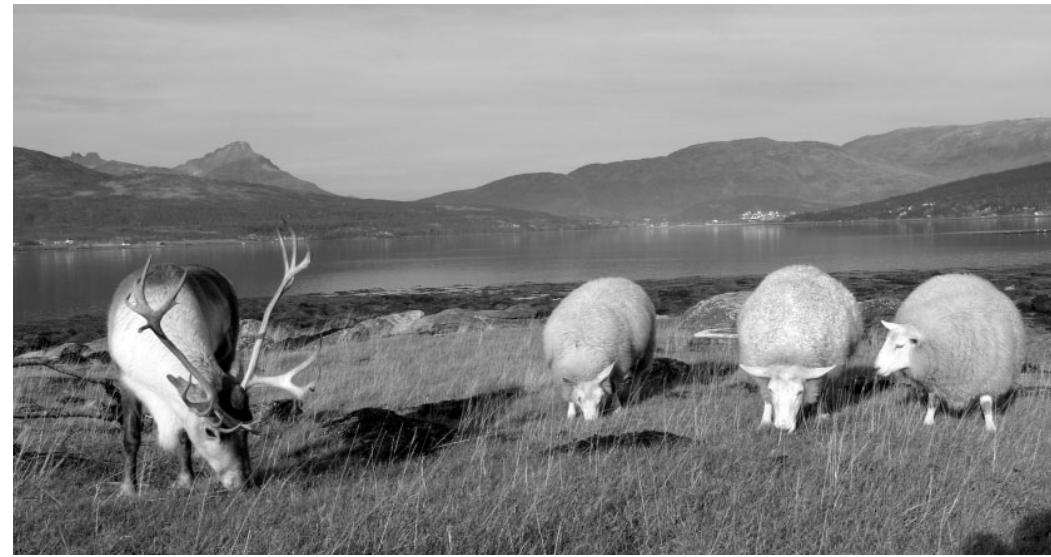
Fig. 2. Semi-domesticated reindeer ( Rangifer t. tarandus ) and domestic sheep ( Ovis aries ) grazing together in Kvaløy/ Sállir, Troms County, northern Norway. Photographer: Terje D. Josefsen. 8 th Oct.